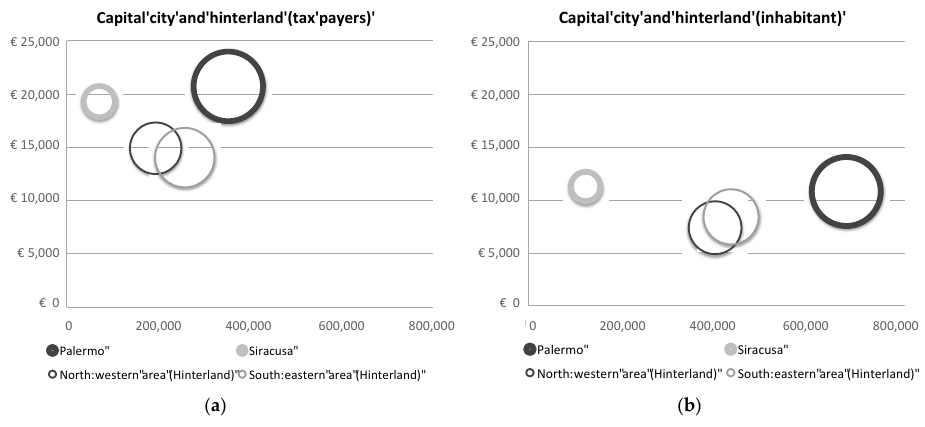
Figure 3. Population ( x -axis) and annual average per capita income ( y -axis) of ( a ) the taxpayers and ( b ) the inhabitants of the capital cities and their hinterlands (our elaboration on ISTAT data).